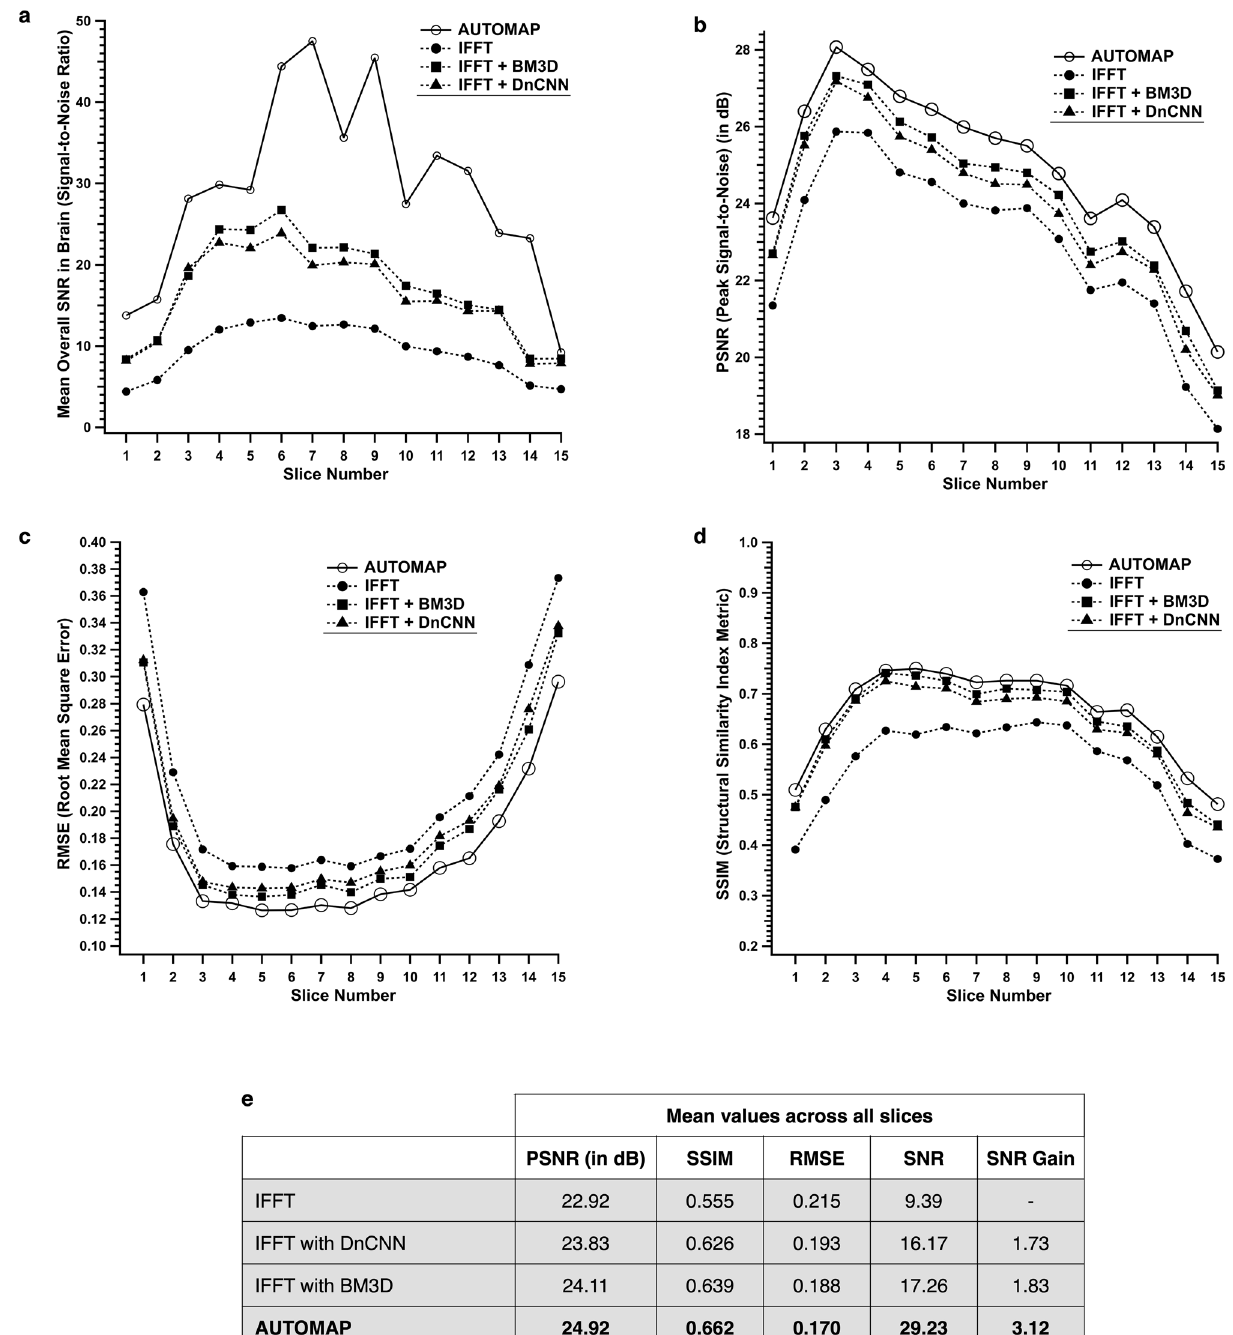
Figure 3. Image metric analysis on the 3D human brain dataset. ( a – d ) Image metric analysis of AUTOMAP and IFFT reconstruction with- and without the DnCNN step or the BM3D denoiser following transformation of the raw k -space data—The mean overall SNR in the whole-head ROI across all the 15 slices is shown in ( a ) for IFFT (filled circle), denoised IFFT with BM3D (filled square) with DnCNN (filled triangle), AUTOMAP (open circle). Three additional metrics are computed: PSNR ( b ), RMSE ( c ), and SSIM ( d ). ( e ) The table summarizes the mean PSNR, SSIM, RMSE, SNR and SNR gain values across all the slices. The SNR gain was calculated with respect to the conventional